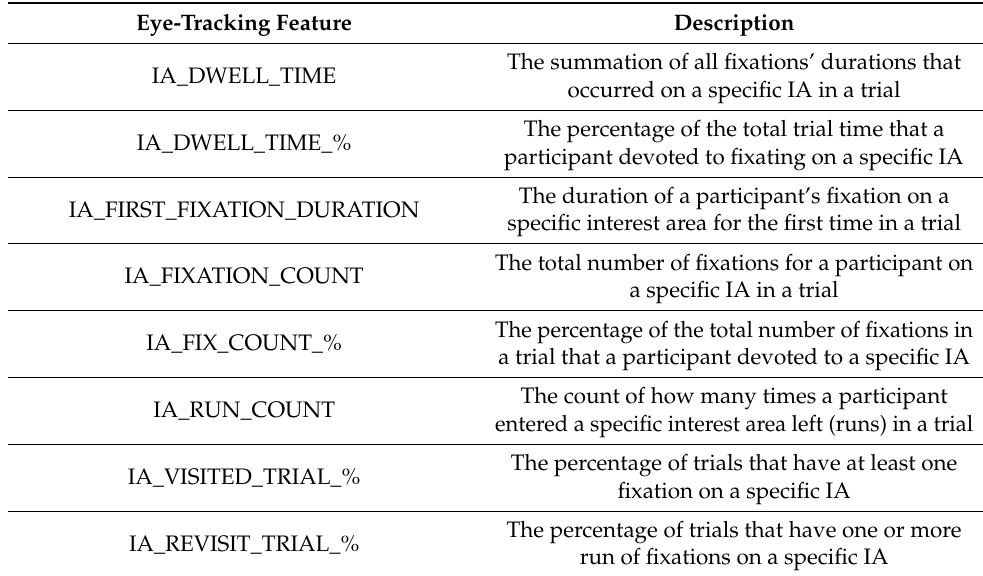
Table 3. Used eye-tracking features for each interest area